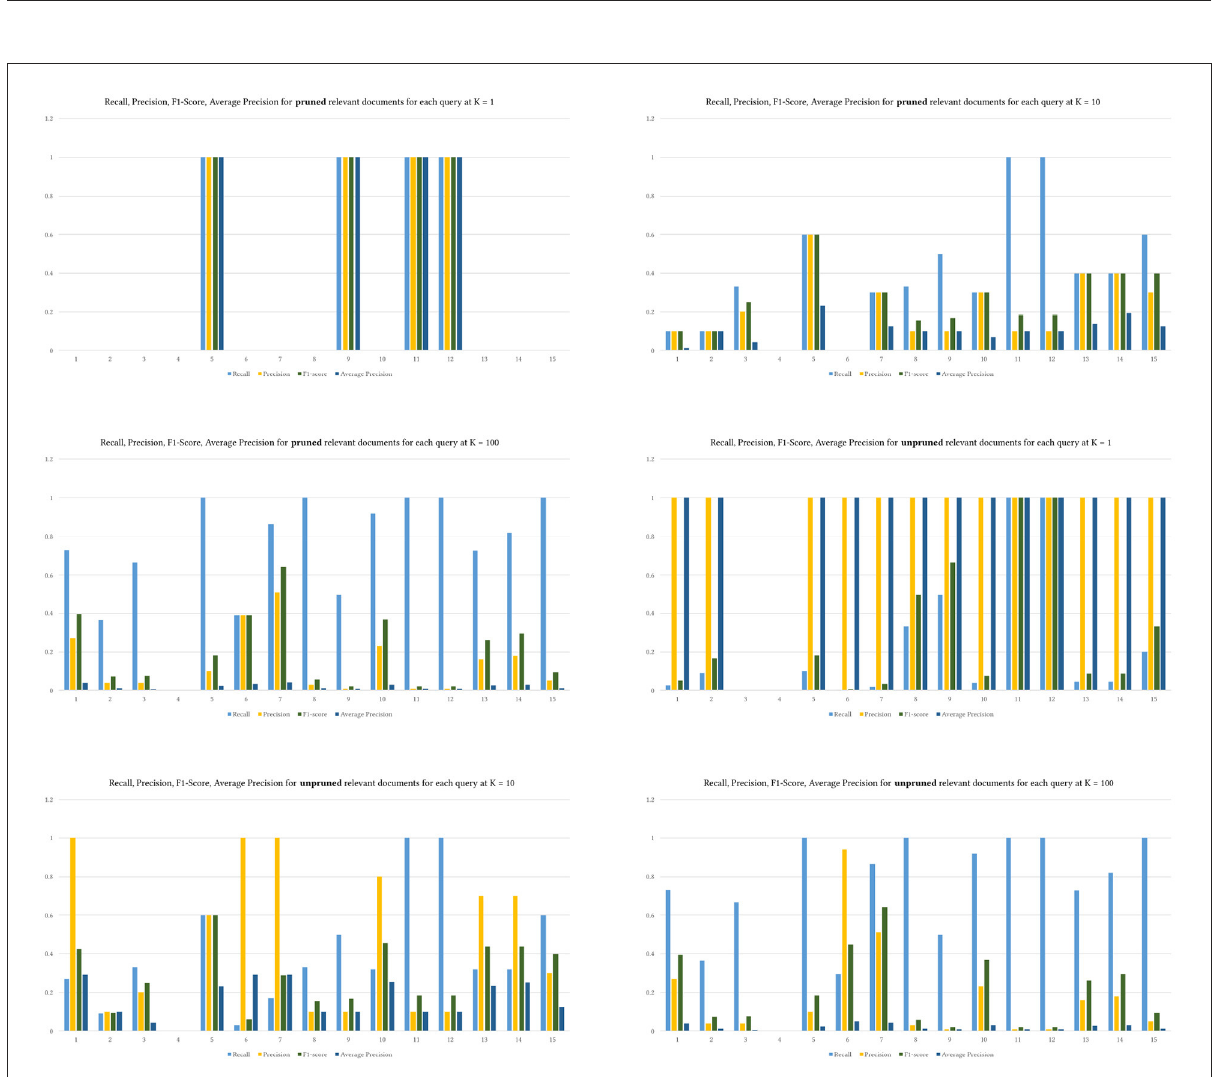
FIGURE8 The four metrics across various levels of K over the 15 queries. Upper is pruned, and lower is unpruned relevant